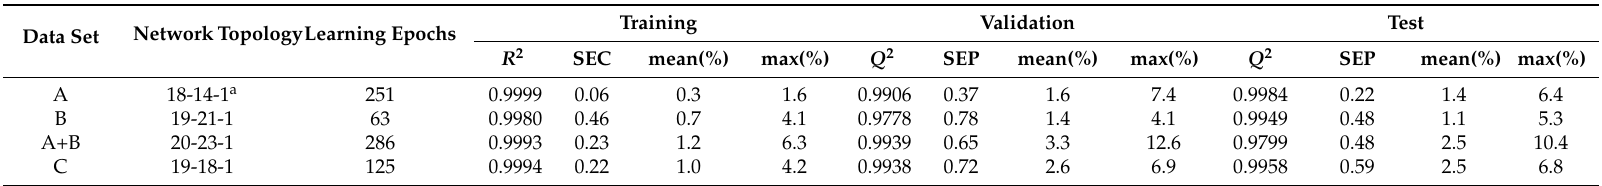
Table 2. Description of the ANN models developed on the retention datasets A, B, A+B, and C: architecture and learning duration of the optimal network, coefficients of determination in training ( R 2 ) and prediction ( Q 2 ) and respective standard errors (SEC and SEP), and the mean and maximum percentage errors (mean(%) and